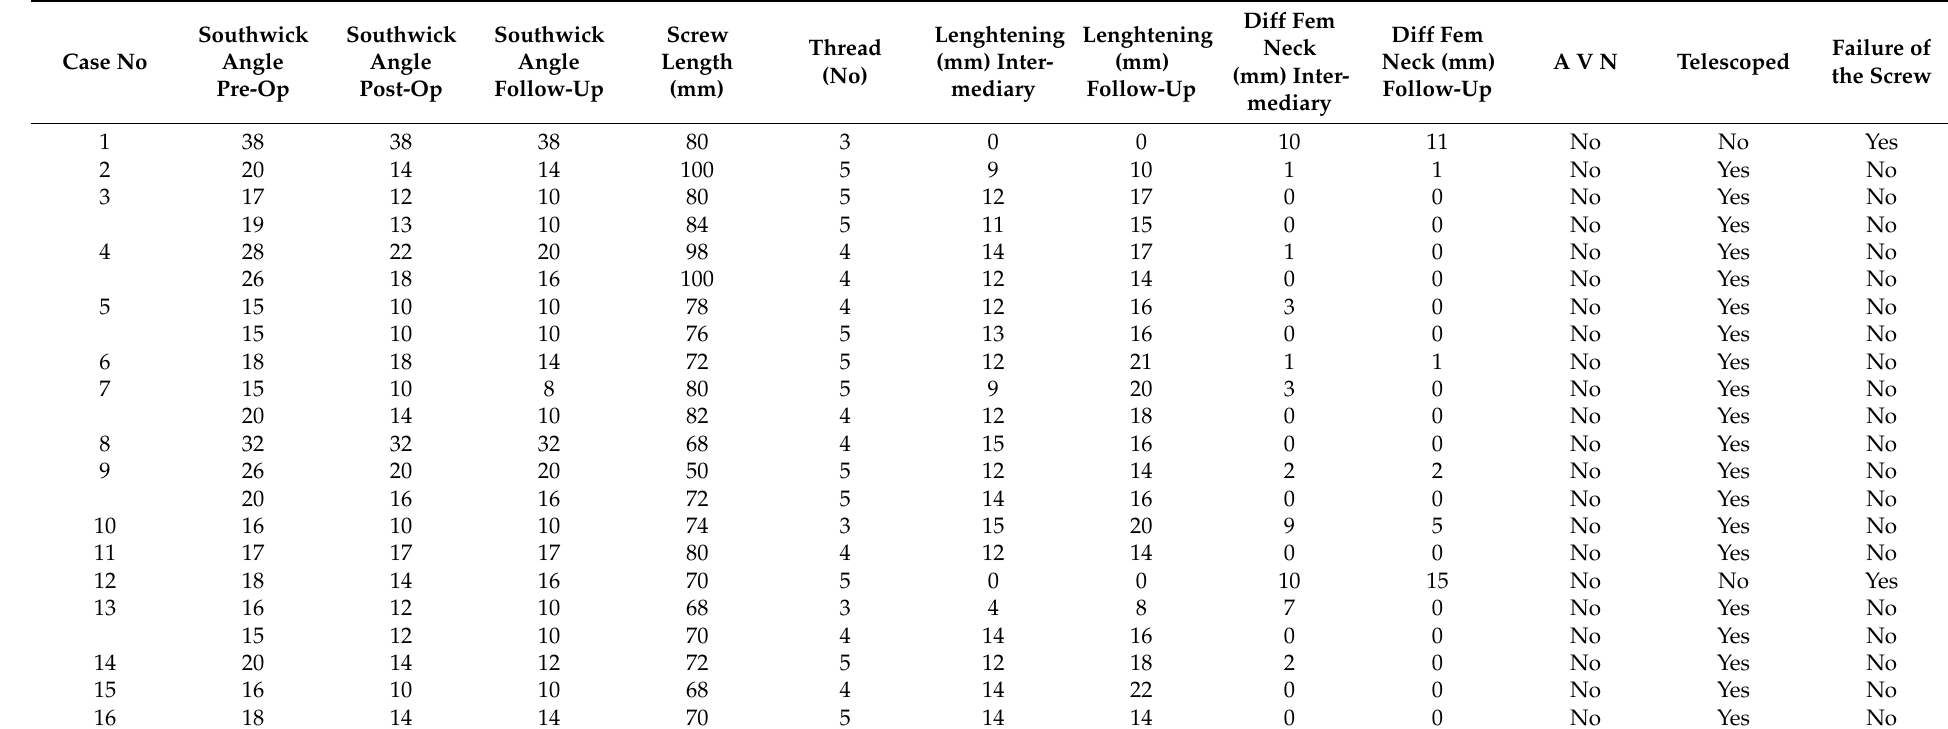
Table 2. Result and Follow-up